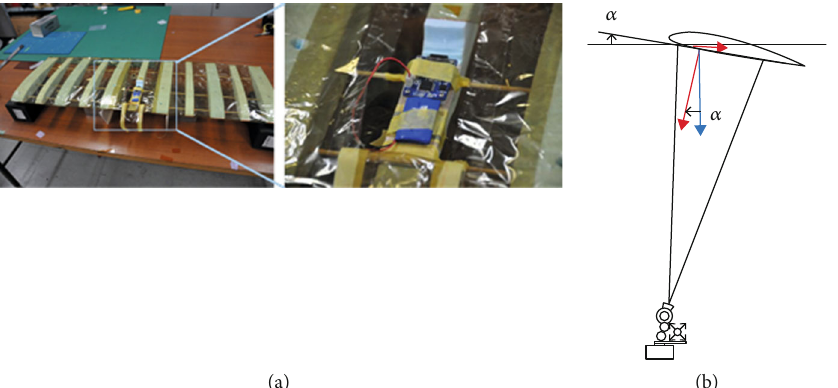
Figure 11: Installation position of a three-axis acceleration sensor-logger. (a) Appearance of the installation position of the sensor-logger. (b) De fi nition of acquired acceleration and gravitational acceleration used in the calculation of the angle of attack of test